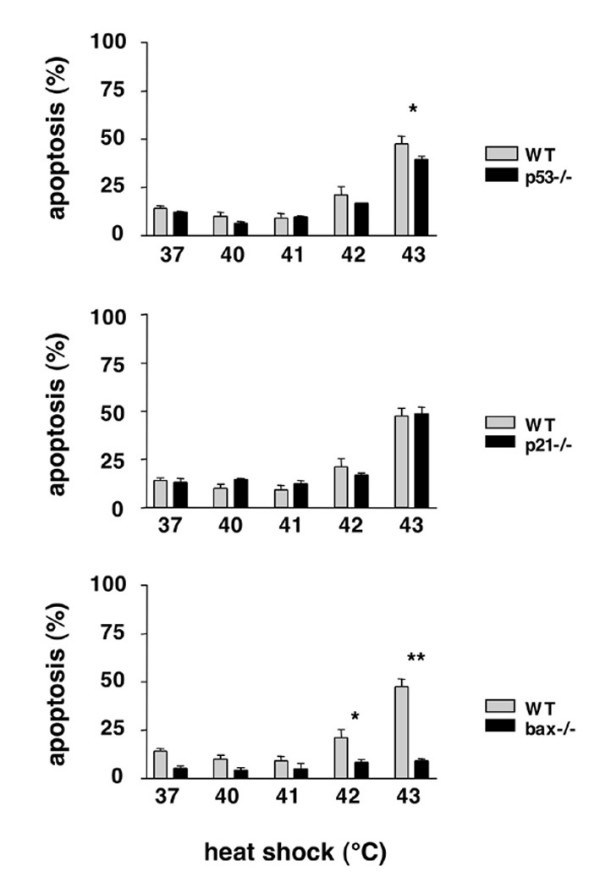
Induction of apoptosis by heat shock. HCT116 cells were exposed to heat shock and cultured for 72 h. Grey bars: wild type. Black bars: knock-out mutants. Upper panel p53-/-, middle panel p21CIP/WAF-1-/-, lower panel Bax -/-. *: p < 0.05, **: p < 0.005.